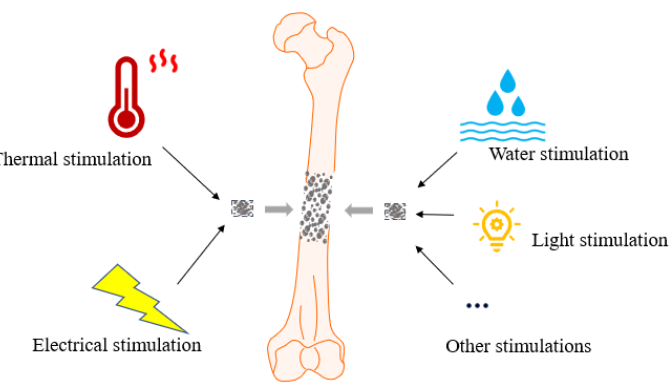
Figure 1. Schematic diagram of SMPs applied to bone tissue engineering after various stimulations.